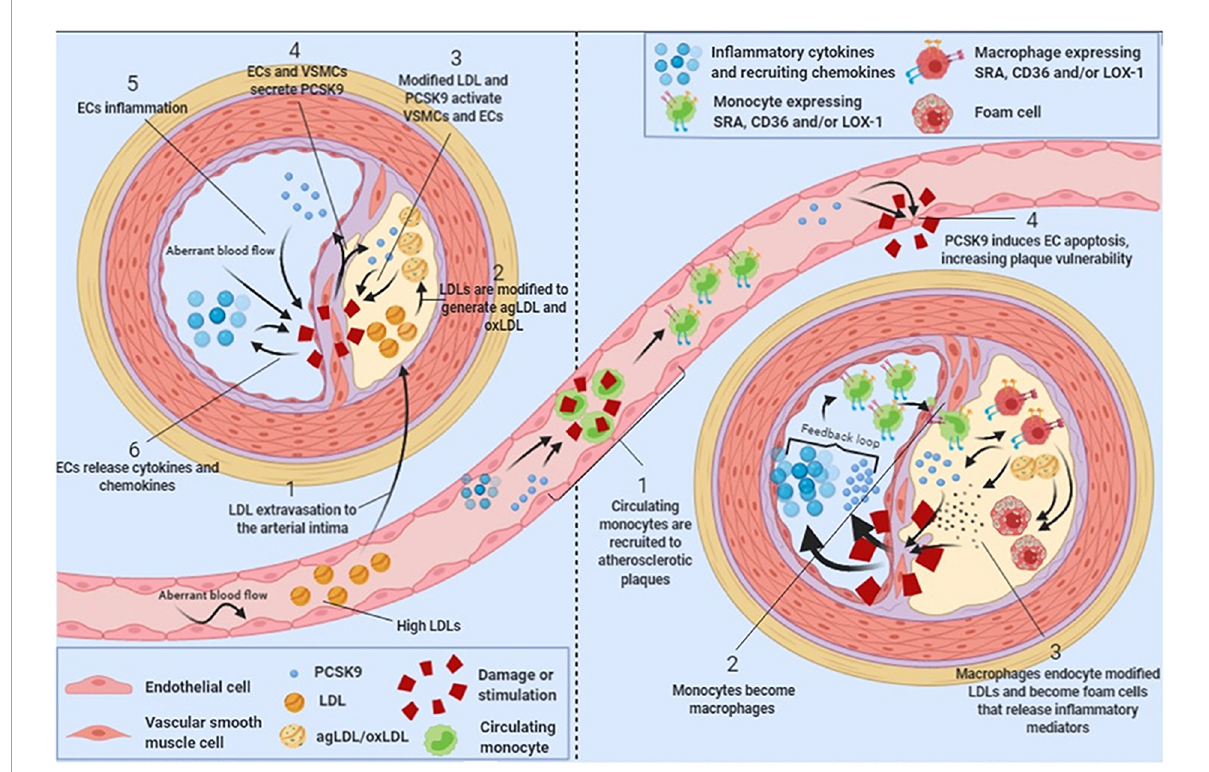
FIGURE2 Schematic showing the role of local intraplaque proprotein convertase subtilisin/kexin type 9 (PCSK9) in atherosclerosis progression. Figure reprinted from Luquero et al. (99) with permission from the authors.